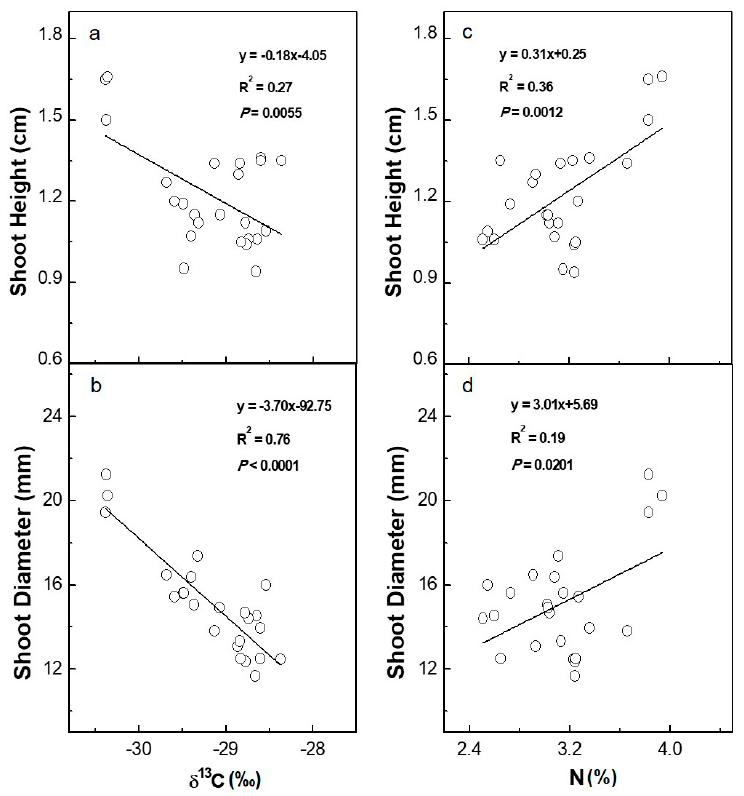
Figure 3. Stable carbon isotope ( δ 13 C, ‰) and total nitrogen concentration (N, %) and their relationships with the height and diameter of shoots in eight 3-year-old mulberry cultivars, three individual trees were measured for each cultivar. Each symbol is the value for one plant per cultivar. The linear regression equations for correlating shoot height and shoot diameter with δ 13 C are y = 0.18x − 4.05 (R 2 = 0.27, p = 0.0055) and y = -3.70x + 92.75 (R 2 = 0.76, p < 0.0001), respectively. The regression equations for correlating shoot height and shoot diameter with N are y = 0.31x + 0.25 (R 2 = 0.36, p = 0.0012) and y = 3.01x + 5.69 (R 2 = 0.19, p = 0.0201), respectively.